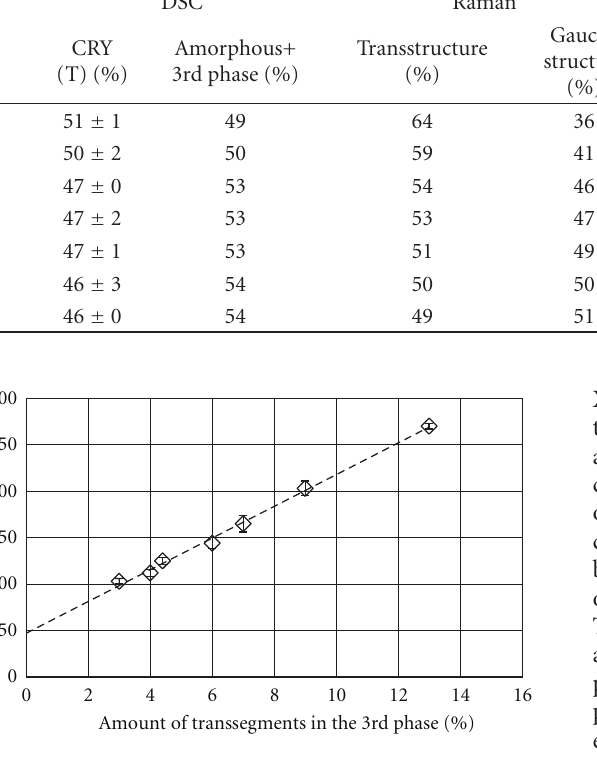
Figure 7: Elasticity modulus as a function of the amount of transsegments in the LLDPE